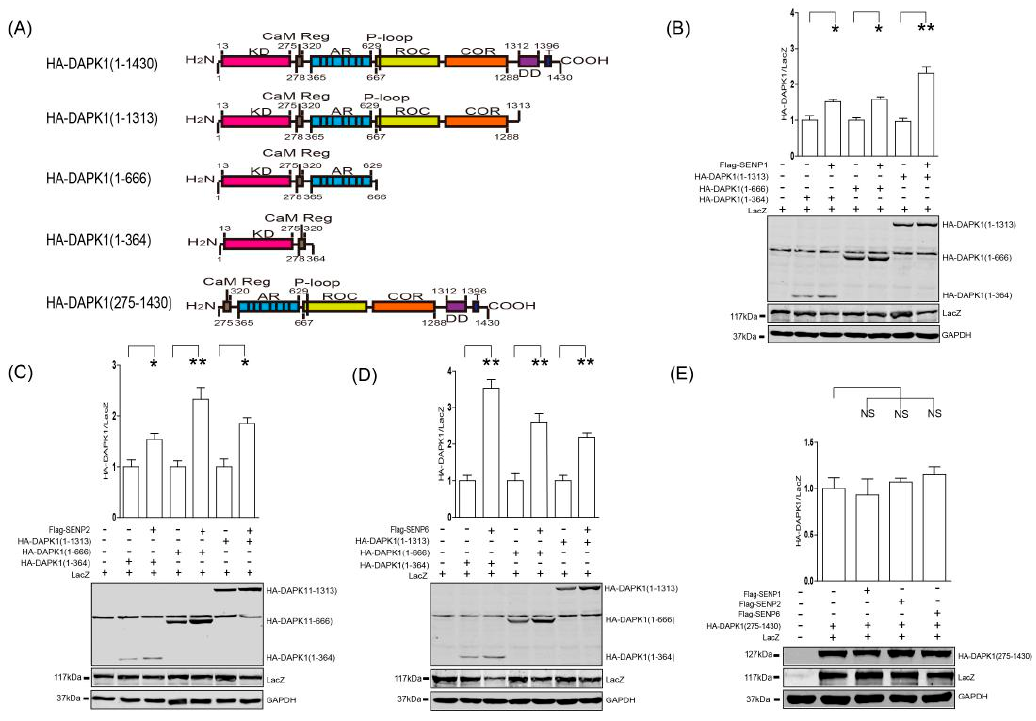
Figure 3. SENPs up-regulated DAPK1 protein levels via the 1-364 kinase domain. ( A ) A diagram illustrating the panel of DAPK1 deletion mutants. ( B–D ) The DAPK1 deletion mutants were co-transfected with LacZ and either Flag-SENP1 ( B ), Flag-SENP2 ( C ) or Flag-SENP6 ( D ), as indicated. ( E ) HA-DAPK (275–1430) mutant was co-transfected with LacZ and either Flag-SENP1, Flag-SENP2 or Flag-SENP6. Cell lysates were extracted 48 h post-transfection and immunoblotted with respective antibodies. The intensity of the bands was quantified using LICOR Odyssey software and represented by bar graphs. The experiments were repeated three times (n = 3) and representative images are presented. The representative western blot images are from different gels and each lane was loaded with the same amount of proteins. Data of triplicate assays are presented as mean ± S.D. * p < 0.05; ** p < 0.01; *** p < 0.001; NS, no significance. “+” indicated that the plasmid was transfected, “ − ” indicated that the plasmid was not transfected.